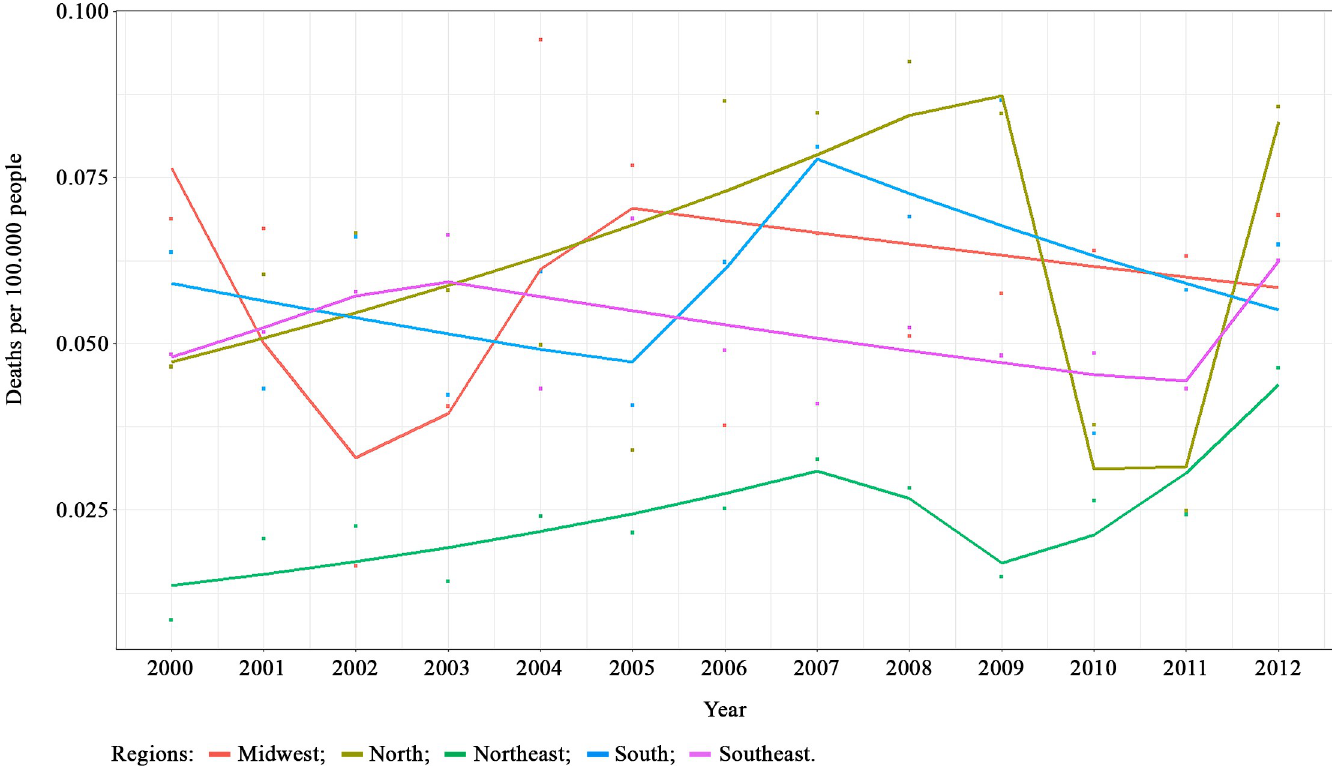
Fig 4. Joinpoint analysis of Cryptococcosis mortality rates according to Brazilian regions between 2000 and 2012 (Basic cause of death). Note: Squared points are the observed mortality rates, line represents the expected mortality rates predicted by a Poisson segmented regression.